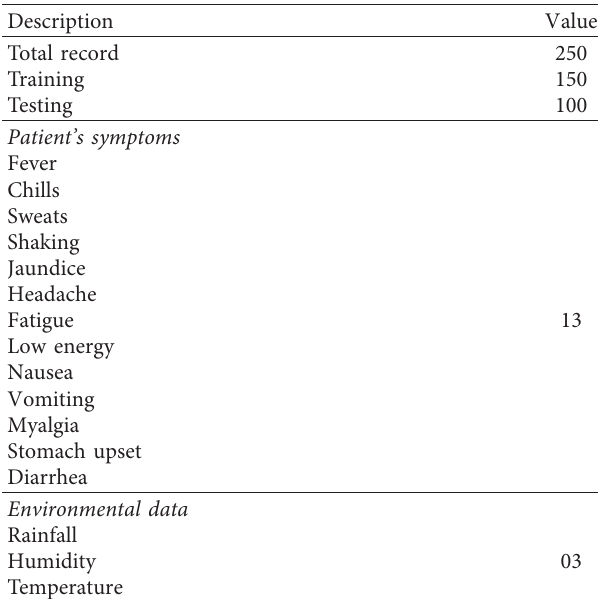
Table 1: Data description table.